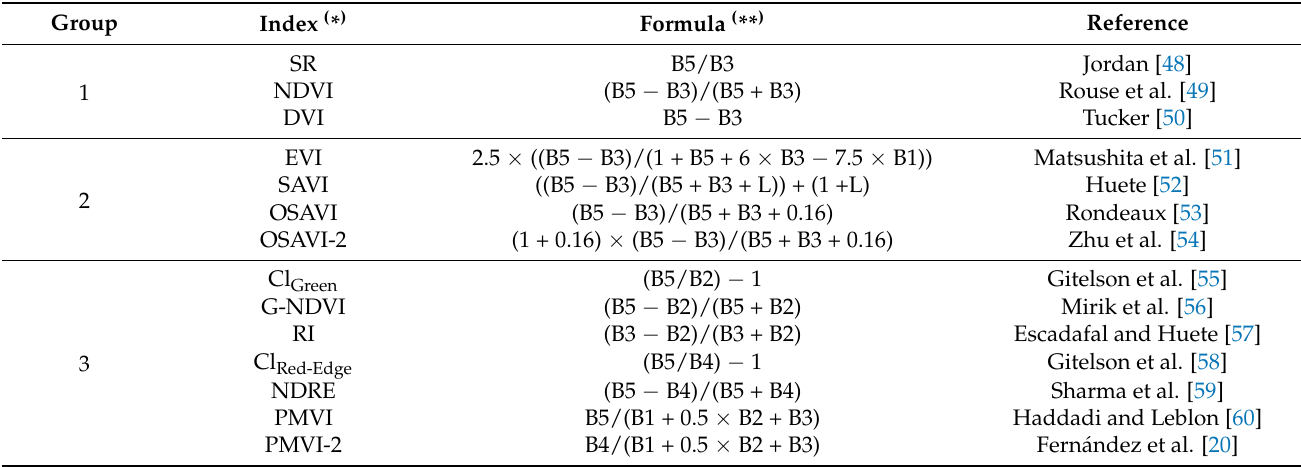
Table 2. Vegetation indices used in this study grouped according to their